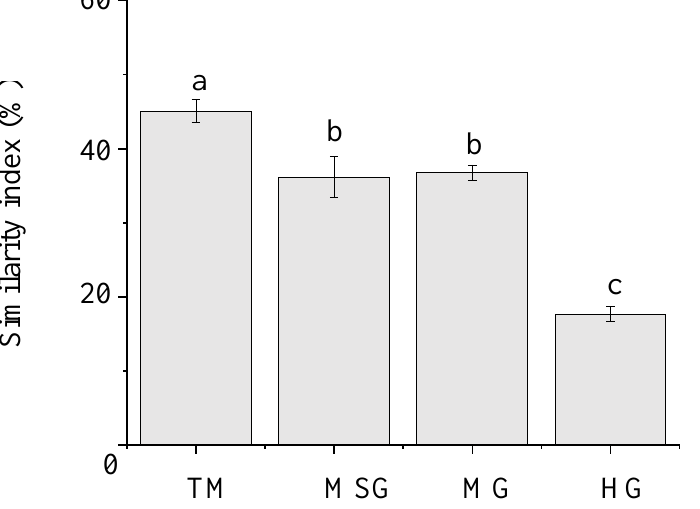
Figure 3. Community similarity of wetlands under different land uses. Different letters indicate significant differences among the four wetlands ( p < 0.05).